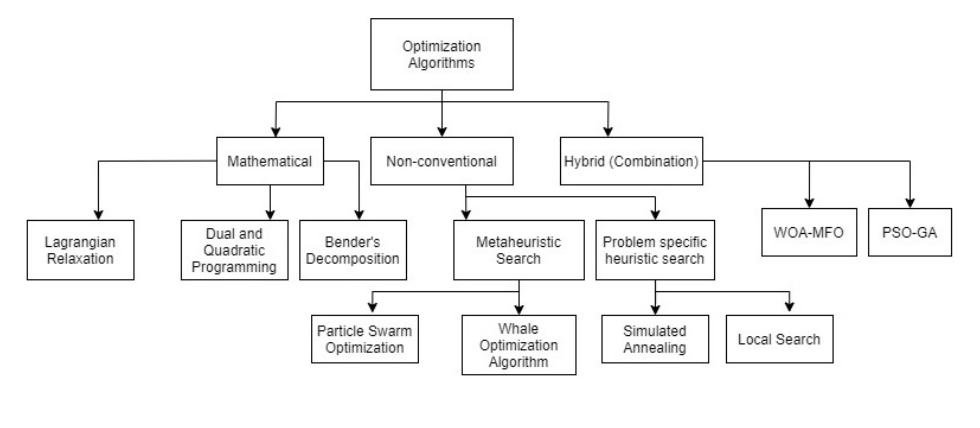
Figure 2. Summary of various types of optimization